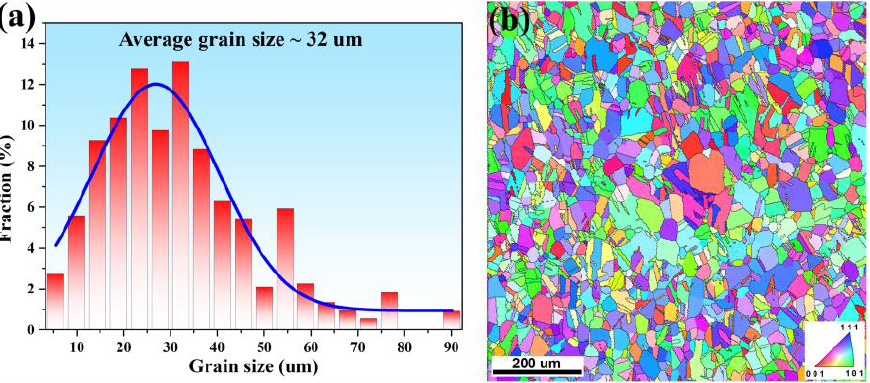
Figure 2. ( a ) Grain size distributions of initial CoCrFeMnNi workpiece; ( b ) a typical EBSD IPF orientation map of the initial workpiece (the inset is the IPF color code).